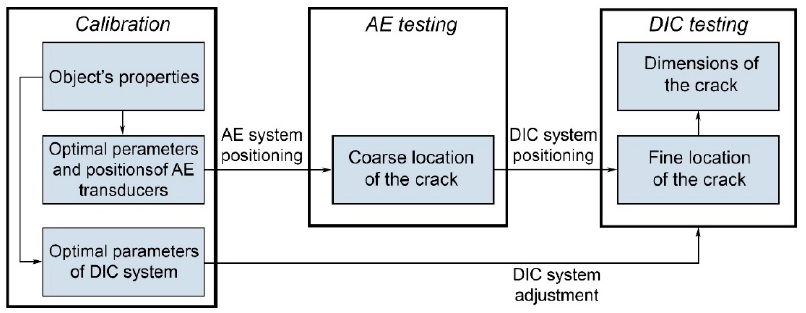
Figure 8. Proposed protocol for AE–DIC inspection.